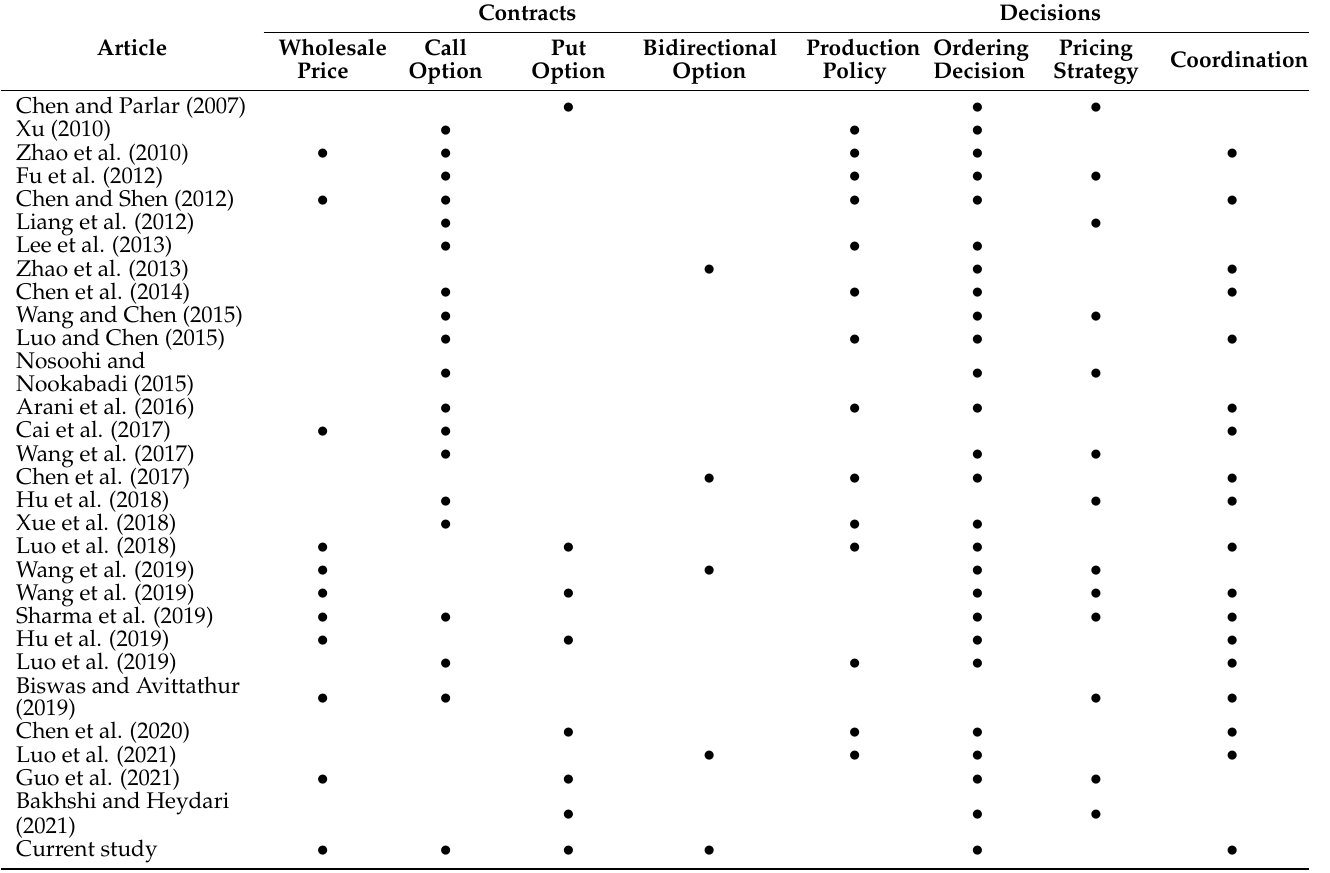
Table 1. Summary of relevant literature under option